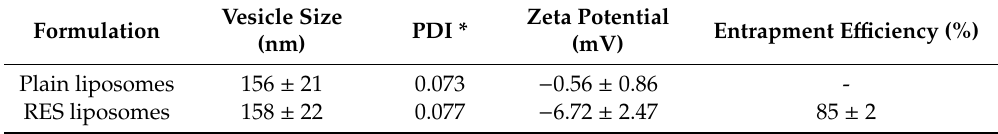
Table 1. Characteristics of plain and RES liposomes. Results are expressed as mean ± SD ( n = 3).